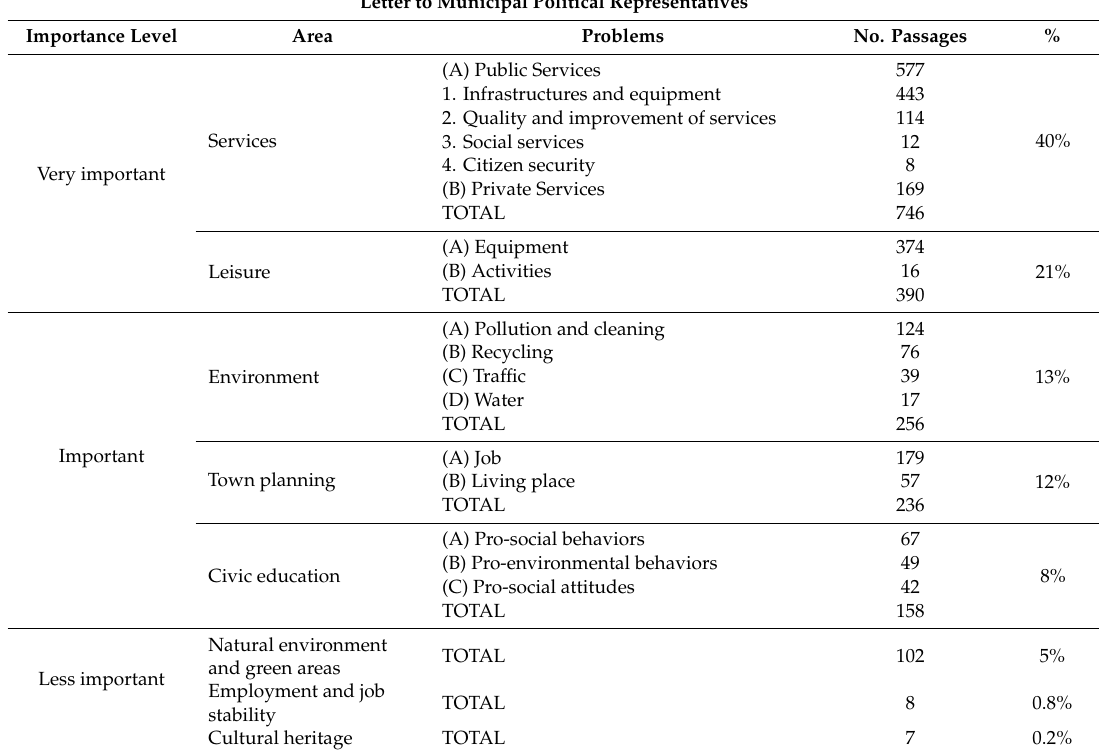
Table 14. Socio-environmental problems extracted from the letter to municipality political representatives.